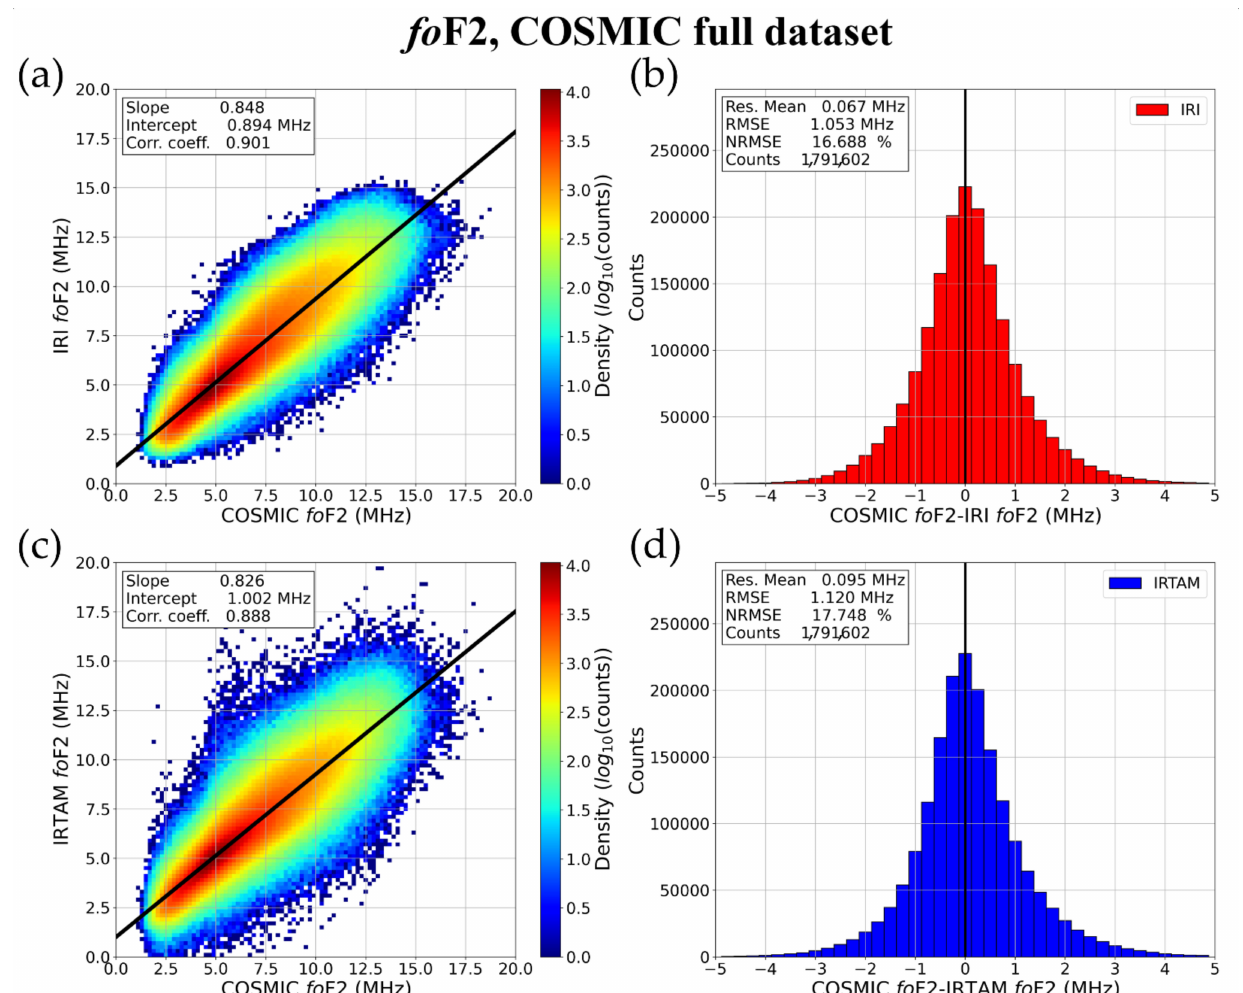
Figure 19. Density plots between measured ( x -axis) and modeled ( y -axis) fo F2 values, for ( a ) IRI and ( c ) IRTAM. Measured values are those from the entire COSMIC dataset. The black solid lines represent the best linear fit. Corresponding slope and intercept values, along with the correlation coefficient, are reported in the upper left box of each plot. Statistical distributions of the residuals between fo F2 values measured by COSMIC and corresponding values modeled by ( b ) IRI and ( d ) IRTAM. Corresponding Res. Mean , RMSE , and NRMSE values, along with the total number of counts on which the statistics is based, are reported in the upper left box of each